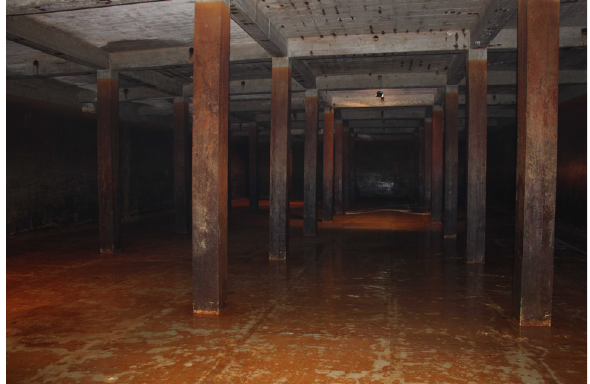
Figure 2: The interior of concrete